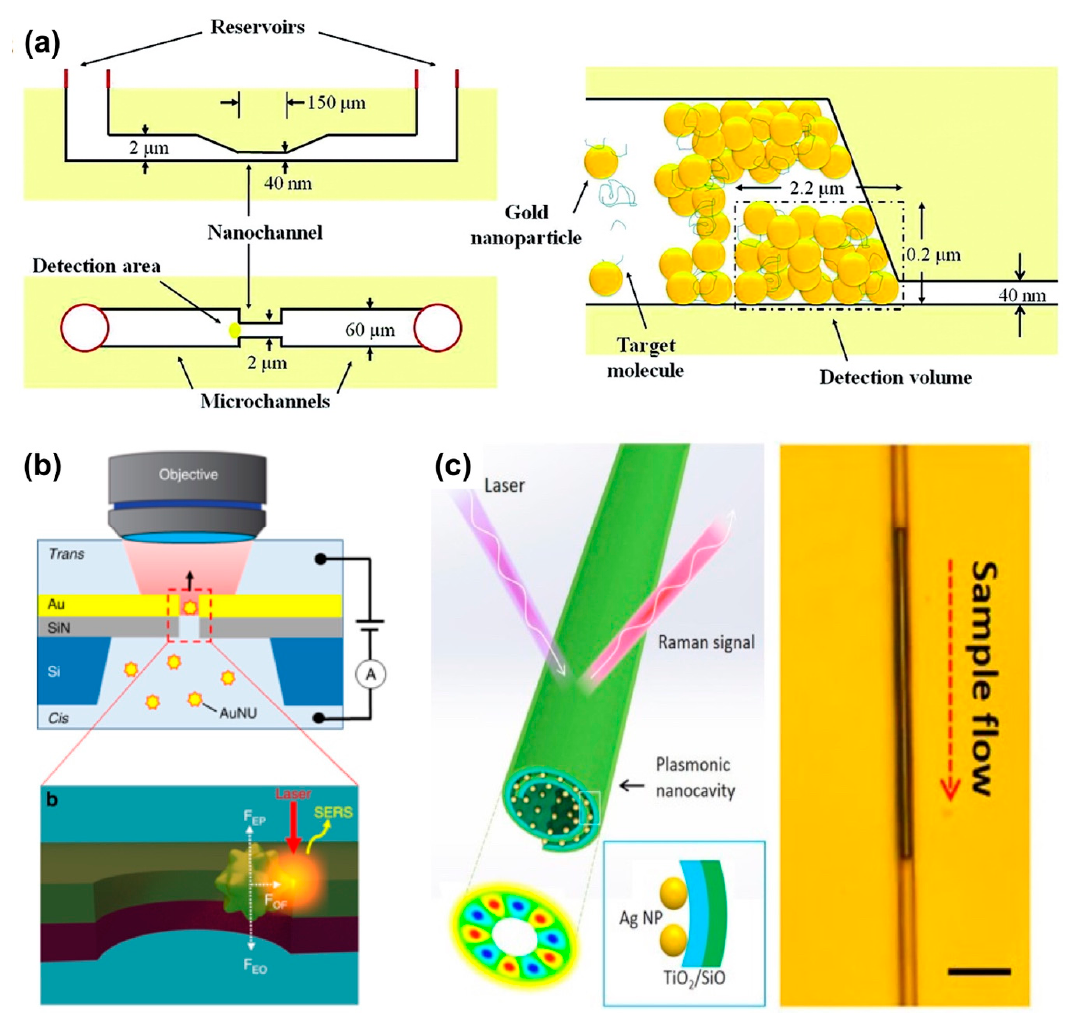
Figure 2. Nanofluidic devices for SERS: ( a ) device exploiting the localization of nanoparticles and preconcentration of target molecules at micro/nanochannel junction (adapted with permission from [51]. Copyright 2011 American Chemical Society), ( b ) electrokinetic capture of a single molecule at a nanopore to increase its residual time (adapted with permission from [55]. Copyright 2019 Springer Nature), and ( c ) self-rolled nanotube integrated with Ag NPs supporting the coupling of whispering- gallery resonances and surface plasmon generated on Ag NPs that improves the enhancement factor in SERS. The scale bar in the right image is 3 μ m (adapted with permission from [56]. Copyright 2015 Springer Nature).